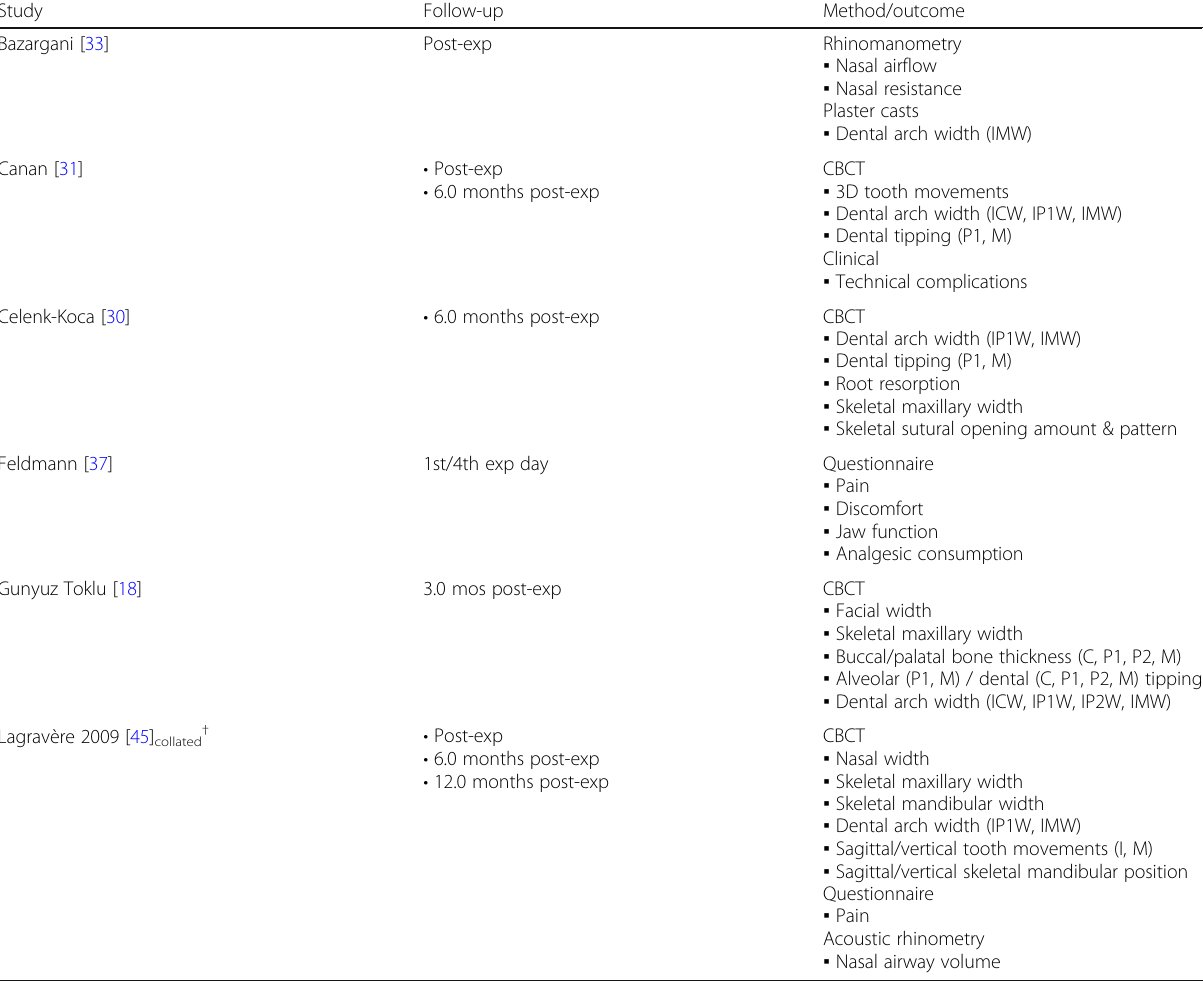
Table 2 Characteristics of included randomized trials pertaining to follow-up and outcome Study